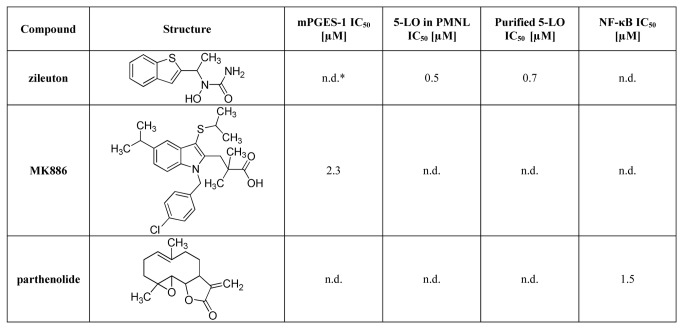
IC50 values of positive controls in mPGES-1, 5-LO and NF-κB assays (n=3).* n.d., not determined.